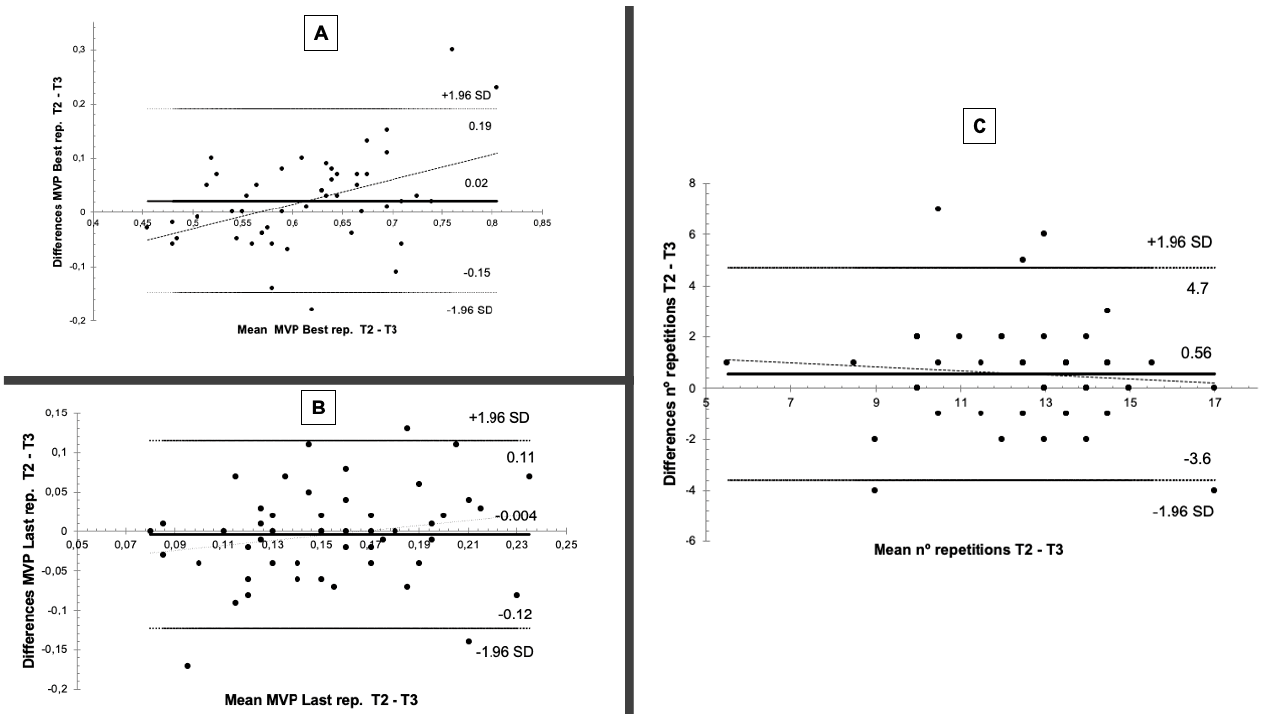
Figure 2. Bland – Altman plots of intra-individual variability (test (T2)-retest (T3)) pertaining to ( A ) mean propulsive velocity attained during the best repetition (MPV Best); ( B ) mean propulsive velocity attained during the last repetition (MPV Last); and ( C ) number of repetitions performed at 70% intensity (MNR).